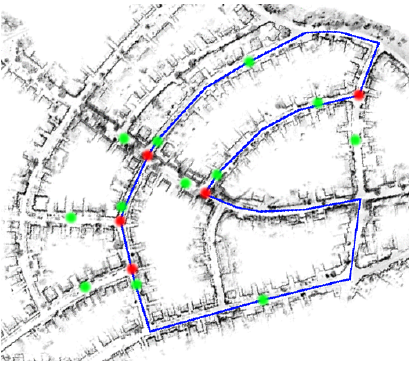
Figure 1. A point cloud projected onto the ground plane, which gives an overview of a district in the city of Ettlingen, Germany. Green markers are points of interest, red markers stand for indirect viewpoints. The blue line is a route that allows to measure all points of